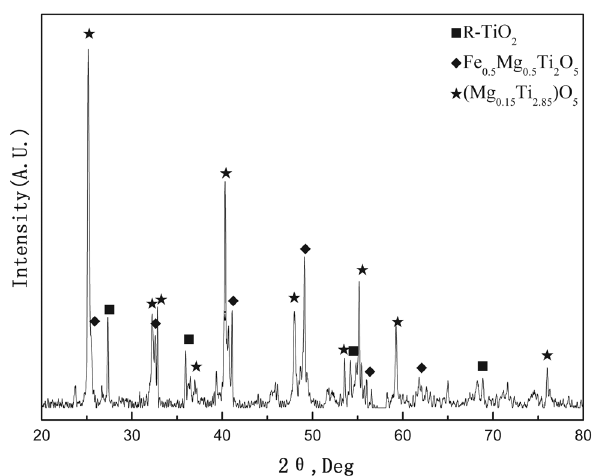
Fig. 1: XRD pattern of high titanium slag